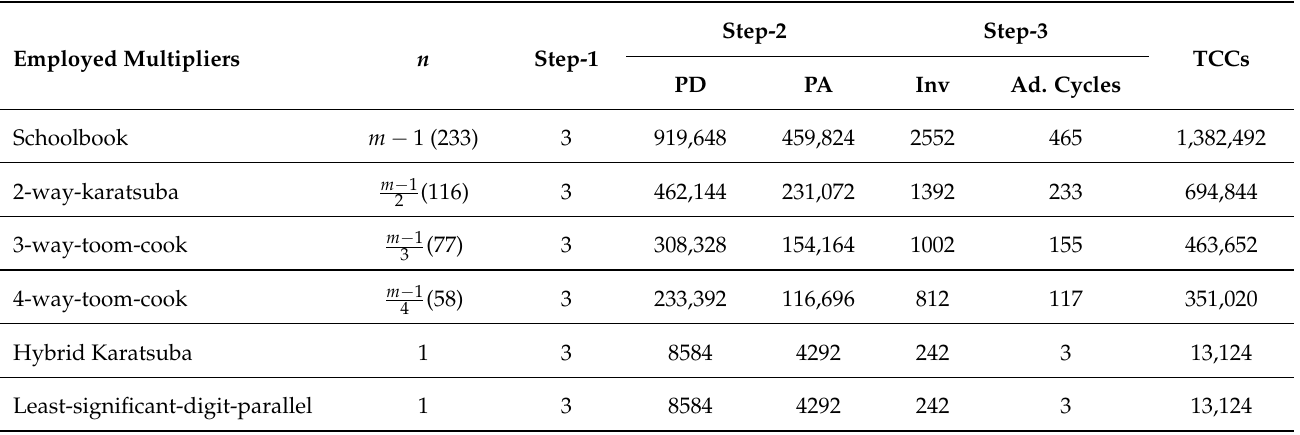
Table 3. Clock cycles for proposed hardware architecture using various finite field multipliers over GF ( 2 233 )